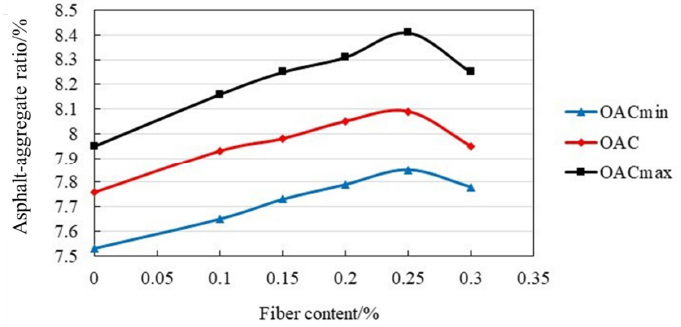
Figure 6. Relationship between fiber content and asphalt-aggregate ratio of SMA-II-2.